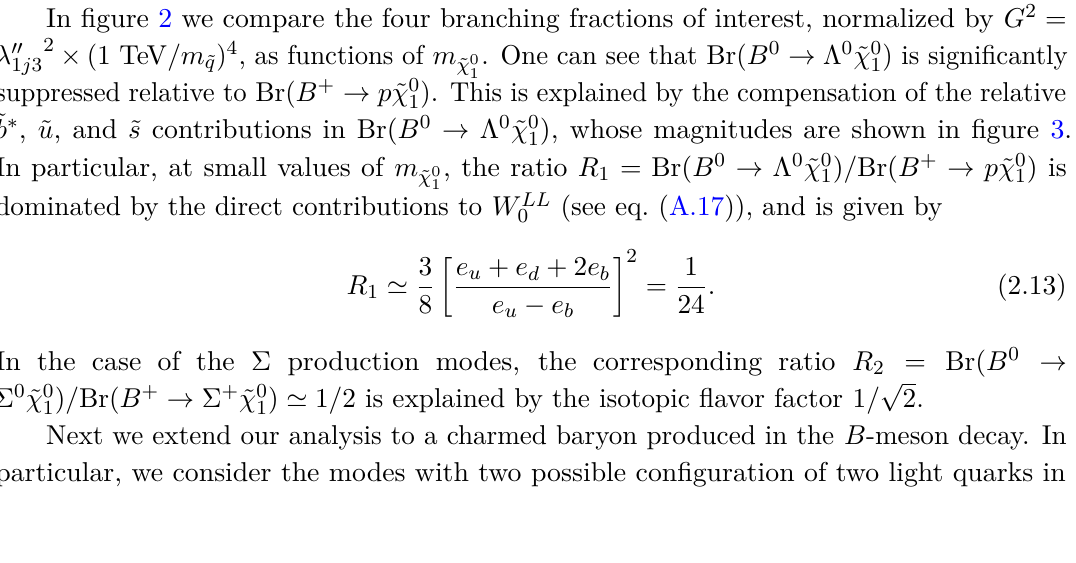
, B + → Σ + ˜ χ 0 , B 0 → Σ 0 ˜ χ 0 , and B 0 → Λ 0 ˜ χ 0 1 1 1 4 , as functions of the neutralino ˜ q )